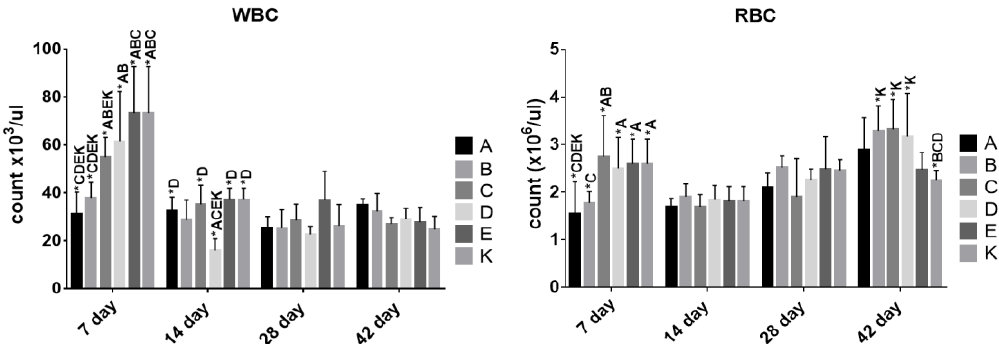
Figure 1. Average red blood cells (RBC) and white blood cells (WBC) count in the blood of the experimental chickens. *—statistically significant di ff erences between groups, p ≤